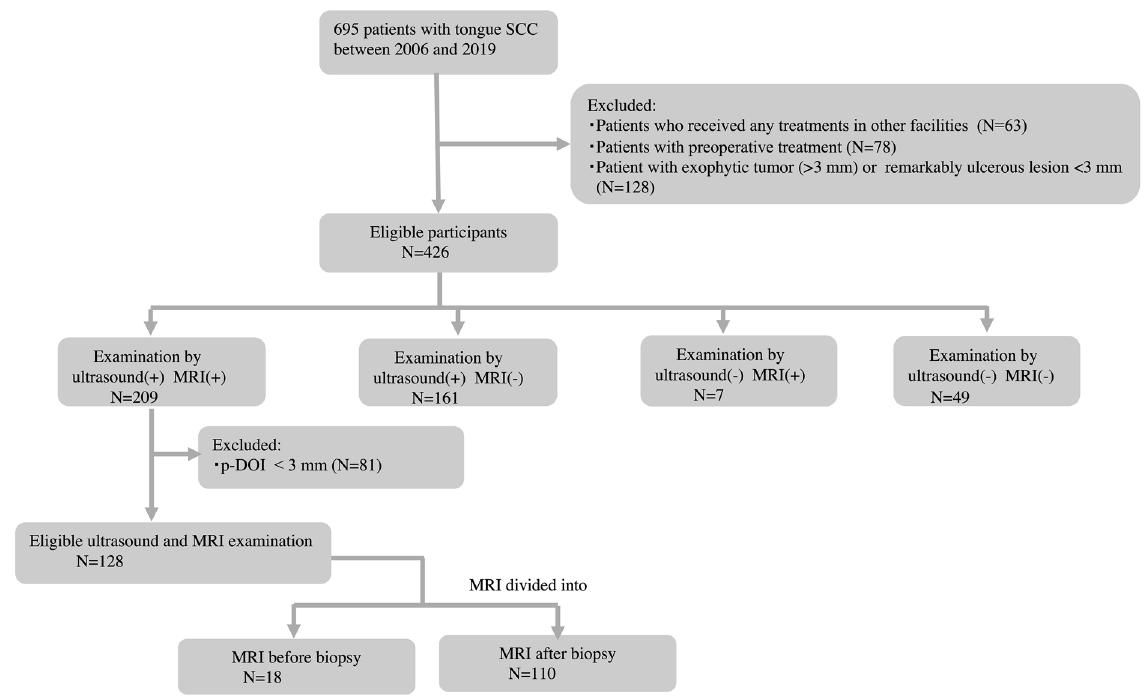
Figure 2. Flowchart of the inclusion and exclusion decision tree. Out of 695 patients, we excluded 63 patients who had received any treatment in other facilities, 78 patients who had undergone preoperative treatment at initial treatment, and 128 individuals who showed exophytic type more than 3 mm from the normal mucosal surface or those with ulceration deeper than 3 mm. There were 426 eligible participants. Out of these,